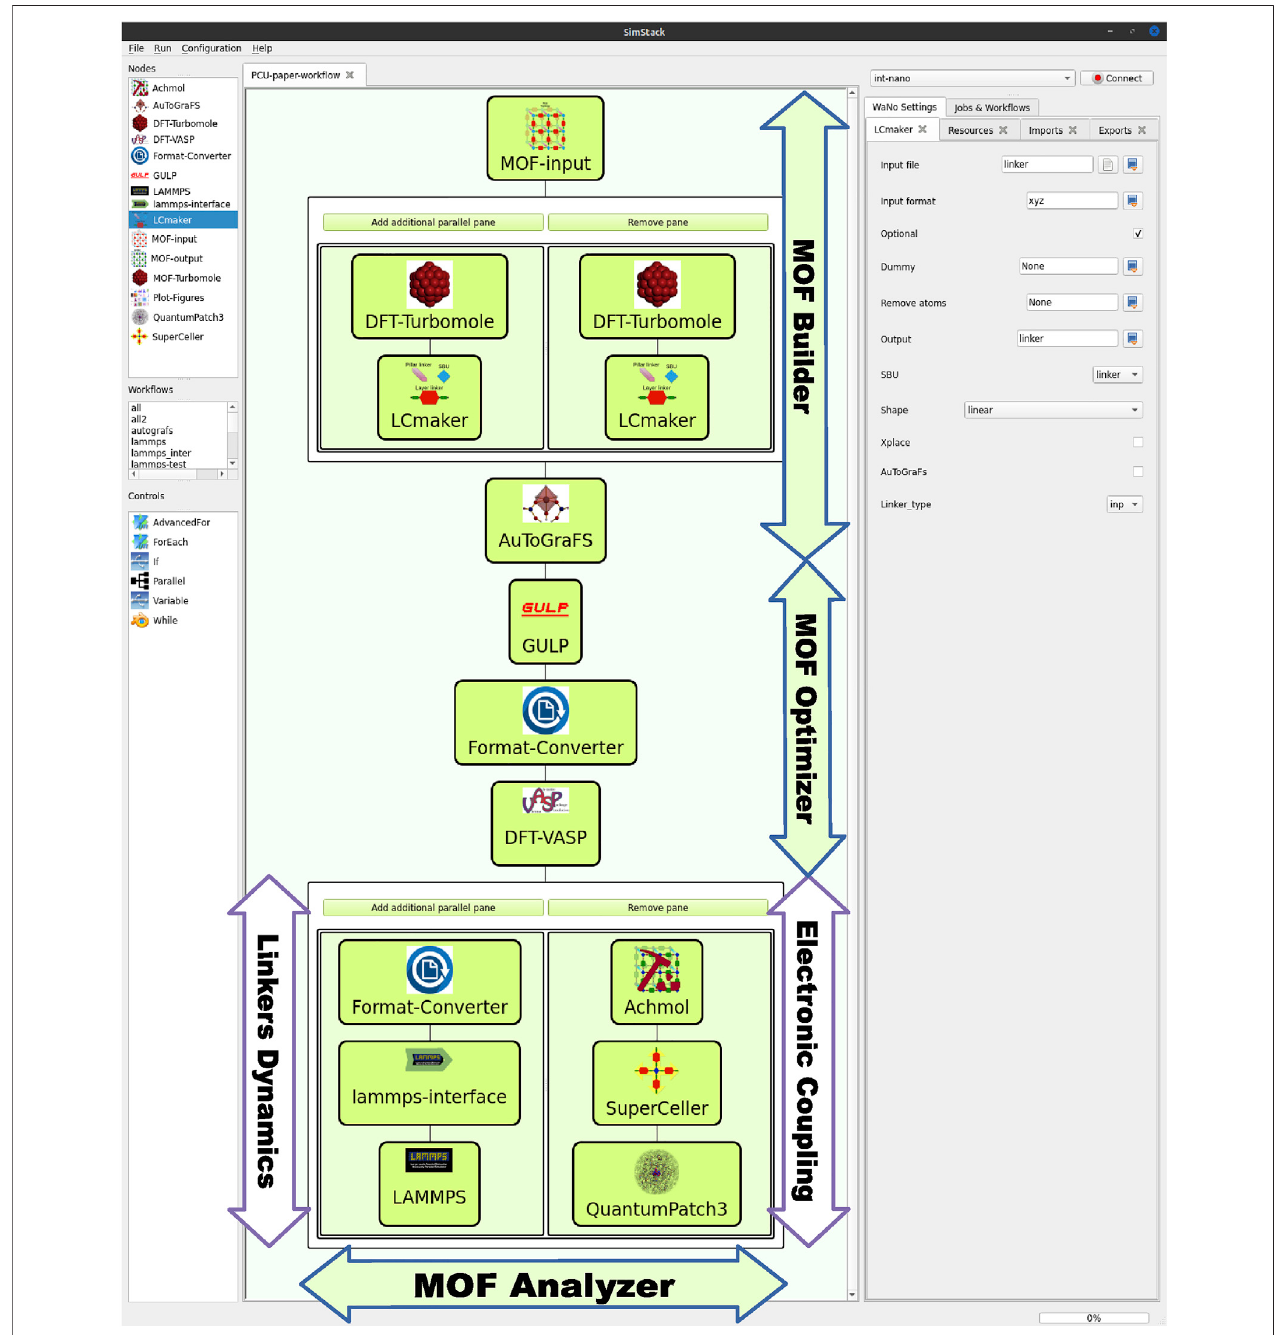
FIGURE3| PCU-MOFwork fl owwithintheSimStackclienttobuild,optimize,andanalyzeMOFmaterialsforautomatedstructure – propertypredictionsanddesign.